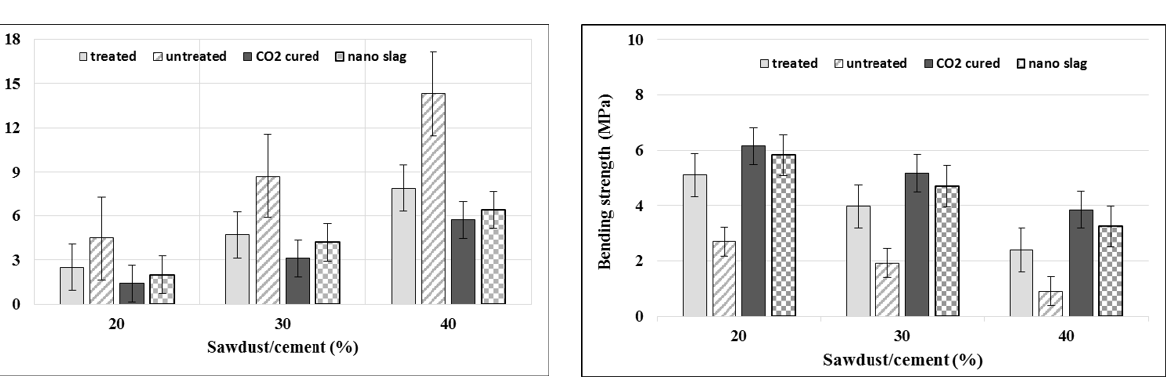
Figure 3: Water absorption of cement-bonded particleboard prior to and after different accelerated effects.